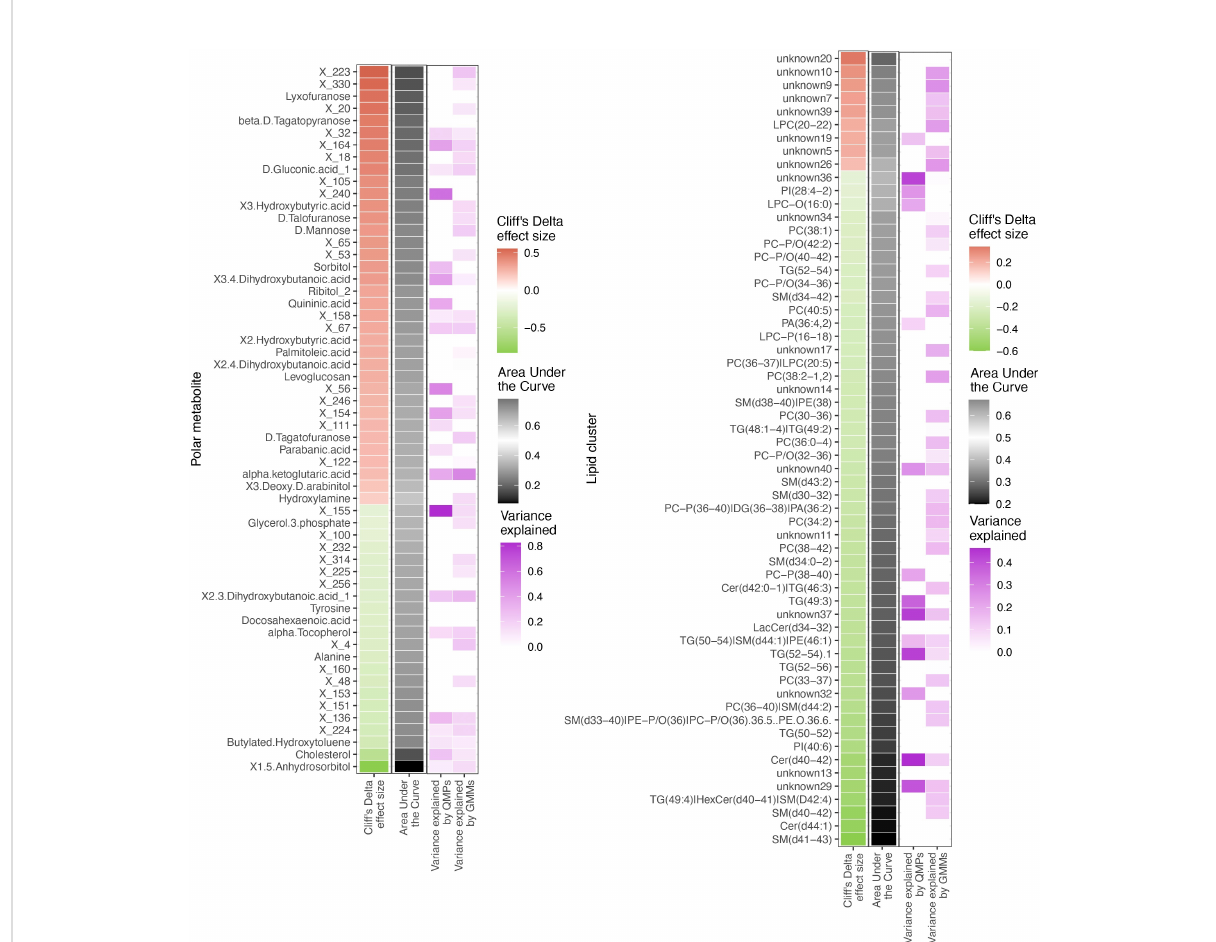
FIGURE 6 Differentially abundant circulating metabolites and microbiome origin and functionality assessment. Summary of the circulating metabolites and lipids data integrated with gut microbiome origin and functionality in the T1D vs healthy controls comparison. The two heatmaps display signi fi cantly contrasted (FDR < 10%) polar metabolites (left) and lipid clusters (right) between T1D and healthy individuals. Column 1 (red green of each of the two heatmaps shows the Cliff ’ s Delta effect size for the clinical group comparison, ordered from higher to lower abundance in T1D individuals and colored from red (higher) to green (lower) gradient depending on its relative abundance in T1D individuals. Column 2 (black- white) shows the usefulness of the metabolite for discrimination between T1D and healthy individuals based on Area Under the Curve (AUC) analyses. The black-to-white-to-black gradient for AUC depicts assessment ability with 50% being uninformative AUC, 0% being the limit for the identi fi cation of healthy individuals and 100% being the limit for identi fi cation of T1D individuals. Column 3 (purple white) depicts relationship between the metabolites and bacterial QMP counts (absolute MGS abundance). Cells are colored if there is any signi fi cant association with metabolite levels (based on LASSO modelling) and the white-to-purple color gradient depicts the explained variance by the microbiome. Column 4 (purple white) depicts the relationship between the circulating metabolites and functional abundance of GMMs. Cells are colored if there is any signi fi cant association with metabolite levels (based on LASSO modelling) and the white-to-purple color gradient depicts the explained variance by the microbiome metabolic potential (or